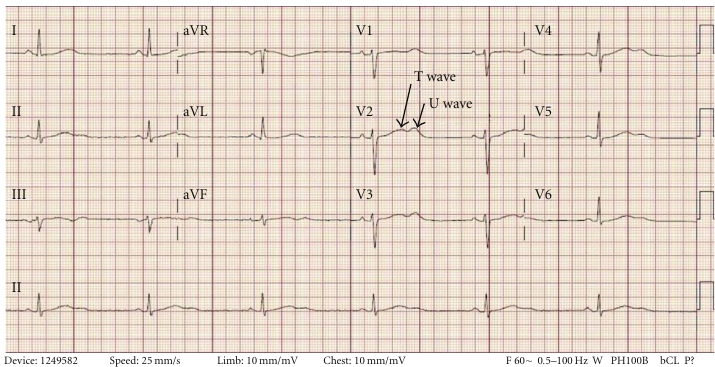
Figure 4: Sinus bradycardia with heart rate of 38beats per minute occurred three days after admission. QTc 571 ms. Also noted are pathological T-U waves.